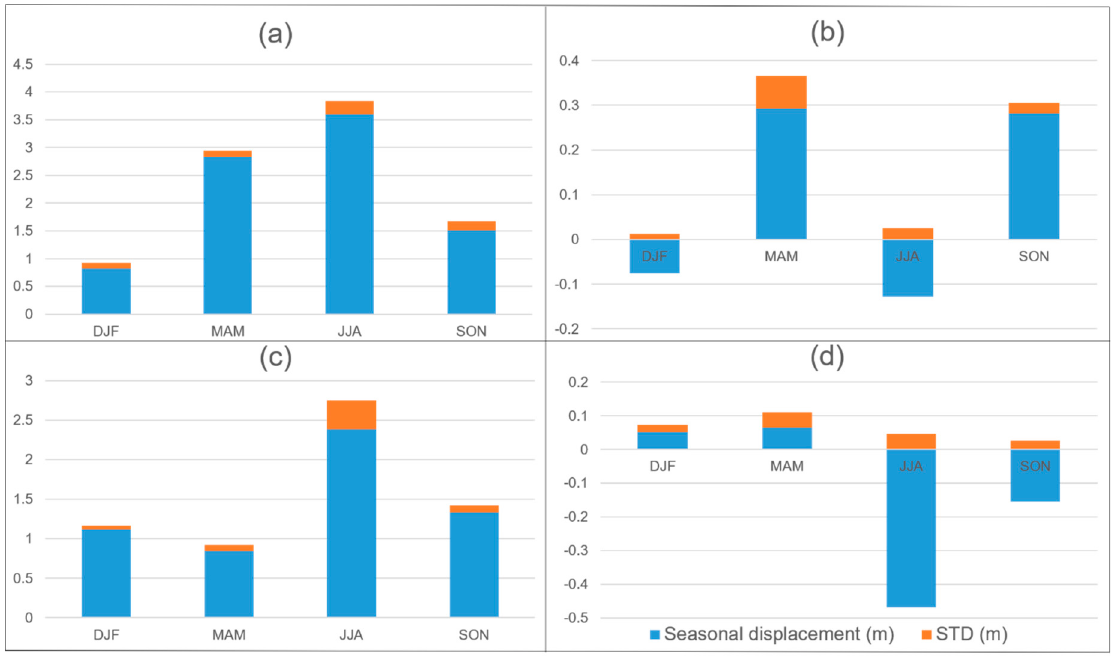
Figure 10. G ra ph of the 3D glacier displacement in four different periods. ( a ) the horizontal displacement for glacier No.1; ( b ) the vertical displacement for glacier No.1; ( c ) the horizontal displacement for glacier No.2; ( d ) the vertical displacement for glacier No.2; DJF: December, January, February; MAM: March, April, May; JJA: June, July, August; SON: September, October, November. The positive values indicate upward movement while the negative values show downward movement, respectively.